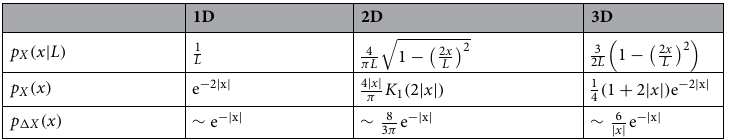
Table 1. Confined one-dimensional PDFs for the particles trapped in 1, 2, 3D spheres. The conditional L ) in the top row are Wigner n -sphere distributions. Middle (i.e. with fixed trap diameter L ) PDFs p X ( x | and bottom rows are the PDFs averaged over the trap sizes, of the displacement X and the increments , (cid:31) t (cid:31) X X t t r respectively. By K 1 we denote the modified Bessel function of the second kind (cid:31) t − X t := ≫ + (see 48 , Eq. 10.32.8]) which has tails K 1 ( 2 asymptotics, but in the case of 1D and 3D the exact values of p (cid:31) X can be calculated by direct integration, the formulas are complicated but may be expressed using special function Ei and